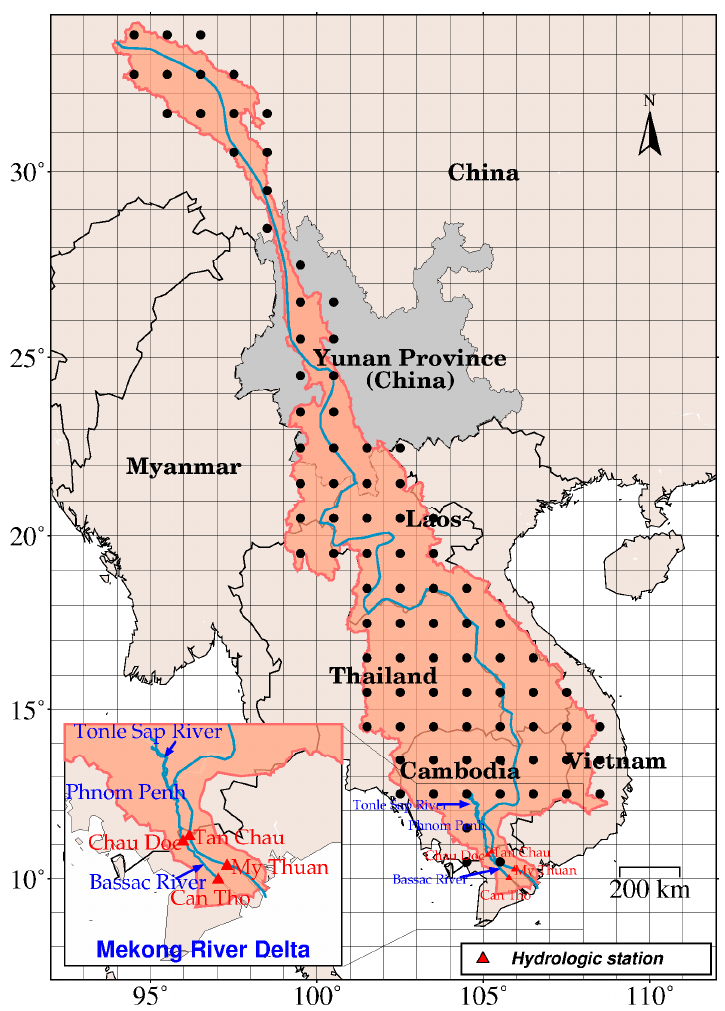
Figure 1. Mekong Basin (in pink) overlapping with Yunnan Province along with ground-observed gauges (in red triangles) within the Mekong Delta. Note that the square grids (with a black dot at each center) overlapping the whole upstream area (from the Tibetan Plateau to the southern boundary of Cambodia) until the entrance of the Mekong Delta are also collected and employed for this study.